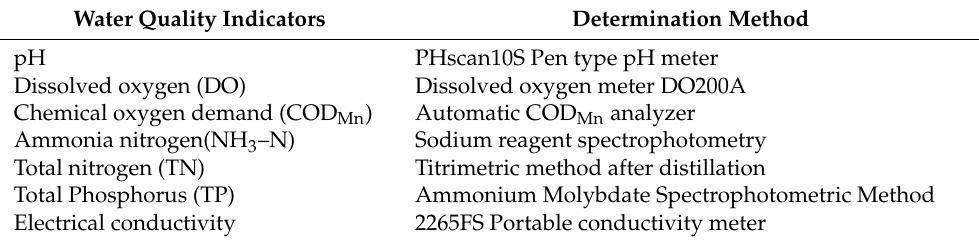
Table 1. Measuring methods of typical water quality indexes.